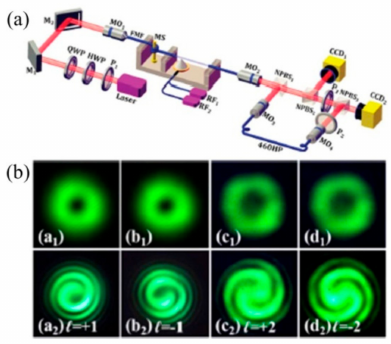
Figure 28. ( a ) Experimental setup for generating the OAM mode by using the cascaded AIFG; ( b ) beam profiles and interference patterns of the VM 11 ± and VM 21 ± [56].